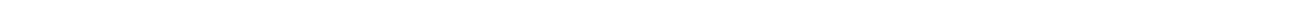
Fig. 3 Human Gle1 CTD binding to DDX19 is IP 6 independent. a − c Zoom view of the IP 6 binding pocket of a S. cerevisiae , b C. thermophilum , or c H. sapiens Gle1 CTD . Residues that are conserved in fungi but not metazoans are highlighted in red. See also Supplementary Figs. 7 and 12. d − f Surface electrostatic potential analysis of IP 6 binding pockets for d S. cerevisiae , e C. thermophilum , or f H. sapiens Gle1. The same view as a − c is shown in surface representation colored by electrostatic potential, from red ( − 10 k B T/e) to white (0 k B T/e) to blue ( + 10 k B T/e), revealing a dramatically reduced electrostatic potential for human Gle1 CTD . See also Supplementary Figs. 5, 10, and 11. g − i SEC analysis of the interaction between Dbp5/DDX19 and Gle1 CTD (cid:129) Nup42 GBM for g S. cerevisiae , h C. thermophilum , or i H. sapiens , in the presence or absence of IP 6 . The elution pro fi les for Dbp5/DDX19 are shown in purple, Gle1 CTD (cid:129) Nup42 GBM and IP 6 are shown in gray, Gle1 CTD (cid:129) Nup42 GBM without IP 6 are shown in orange, Dbp5/DDX19 with Gle1 CTD (cid:129) Nup42 GBM and IP 6 are shown in light blue, and Dbp5/DDX19 with Gle1 CTD (cid:129) Nup42 GBM without IP 6 are shown in black. Fungal Gle1 CTD (cid:129) Nup42 GBM interacts strongly with the Superdex matrix in the absence of IP 6 . The gray horizontal bar indicates fractions visualized with Coomassie-stained SDS-PAGE gels shown